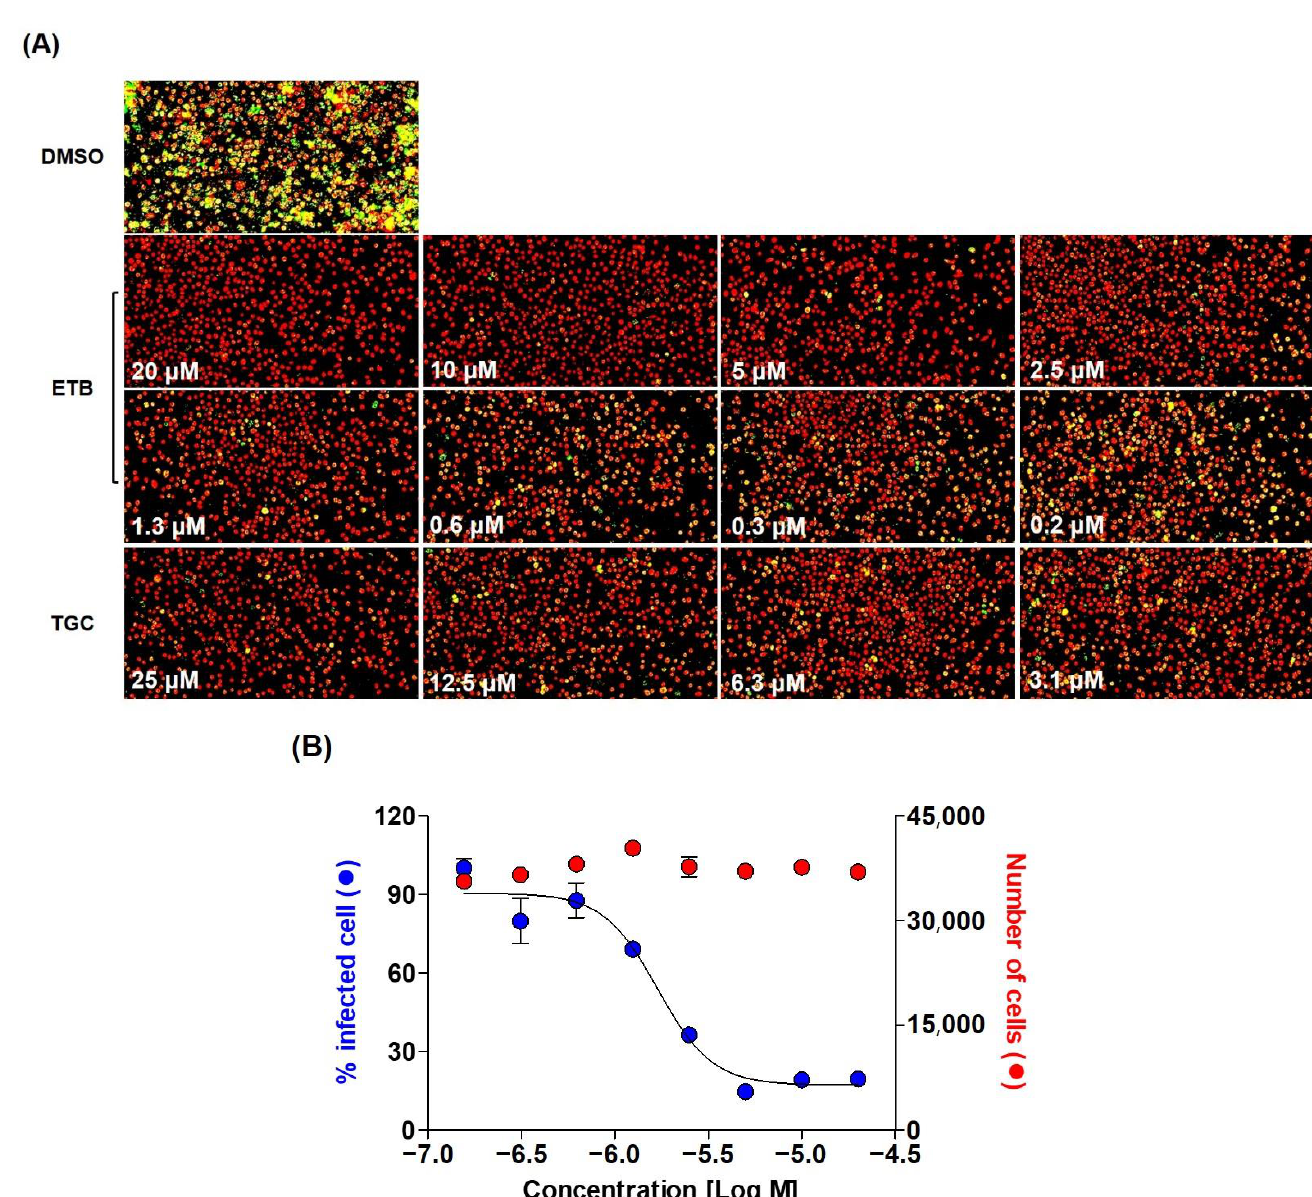
Figure 3. Intracellular activity of ETB against Mab S-mWasabi. ( A ) Images of Mab S-mWasabi infected mBMDMs on day 3 after treatment with different doses of ETB and TGC. DMSO was used as negative control. After 3 days of incubation with antibiotics, mBMDMs were stained with syto60 (red), and the cells were analyzed using the automated cell imaging system. The yellow colors represent Mab S-mWasabi that were phagocytized by red-stained mBMDM cells. The pixel intensities of live Mab S-mWasabi (blue closed circle) and cell number (red closed circle) were quantified after treatment with ETB ( B ) using CellReporterXpress ® Image Acquisition and Analysis